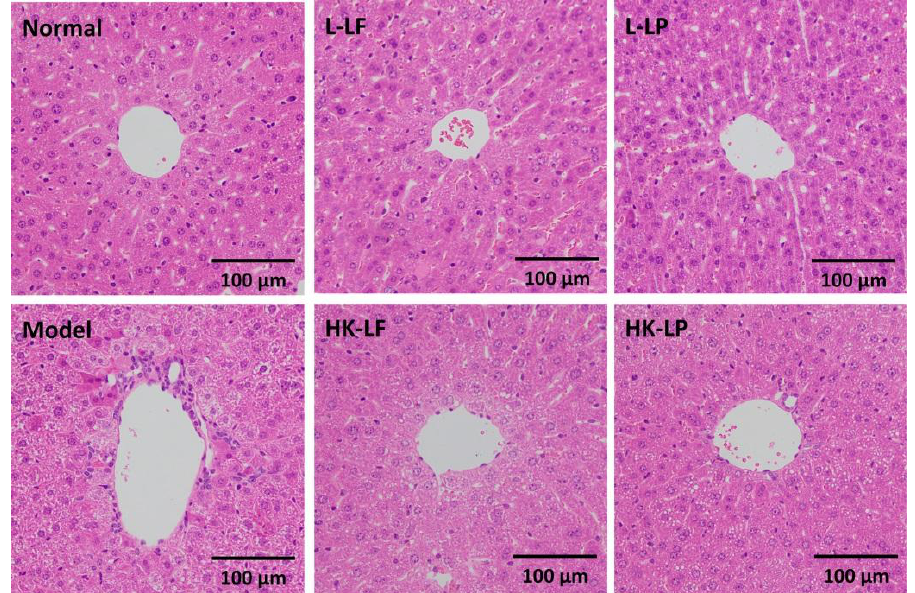
Figure 6. Histopathological observation of the liver (×200). L-LF: live LF group; HK-LF: heat-killed LF group; L-LP: live LP group; HK-LP: heat-killed LP